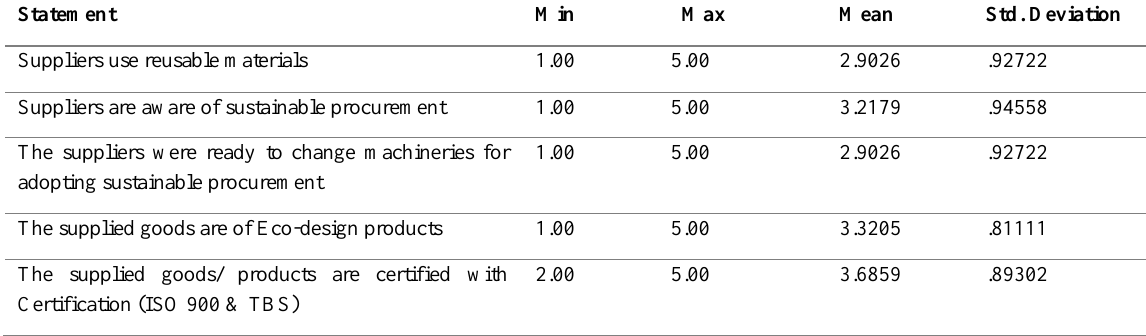
Table 7: Effect of Supplier Awareness on Sustainable